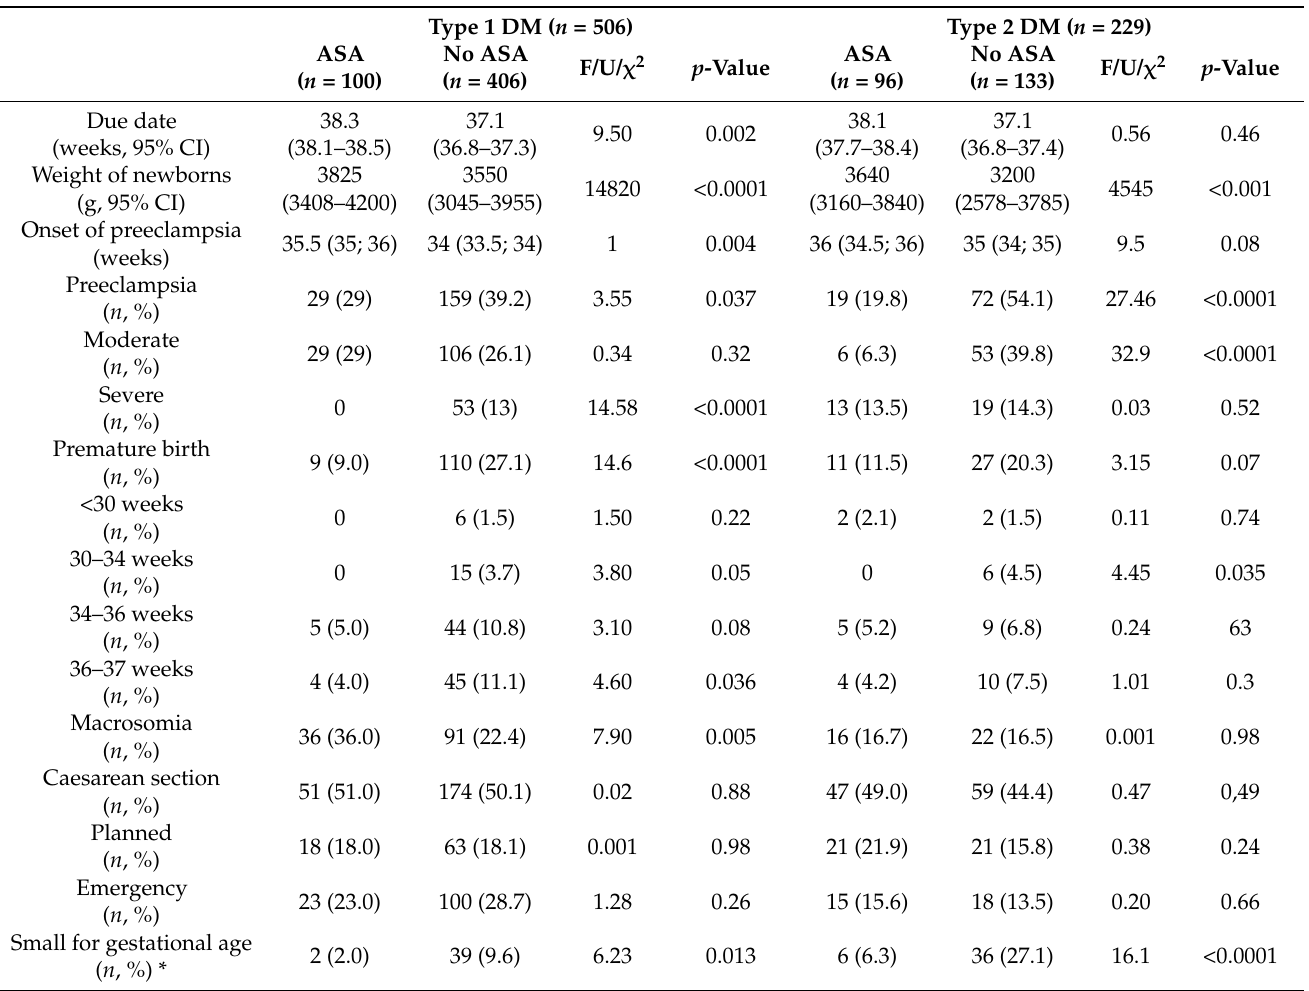
Table 2. Comparison of pregnancy outcomes in patients with diabetes mellitus who received or did not receive an- tiplatelet